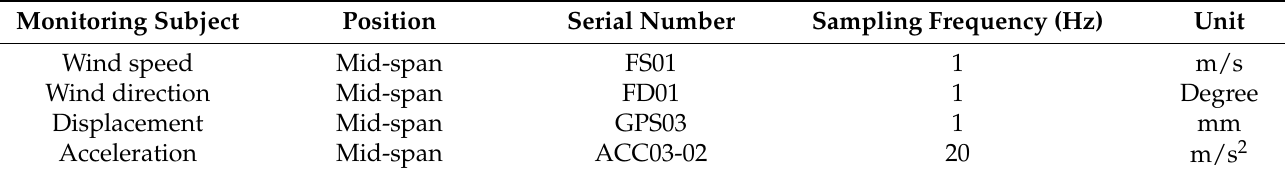
Figure 3. Elevation of the Anqing Yangtze River Bridge and sensor placement (unit: m). Table 2. Sensor displacement and specification.